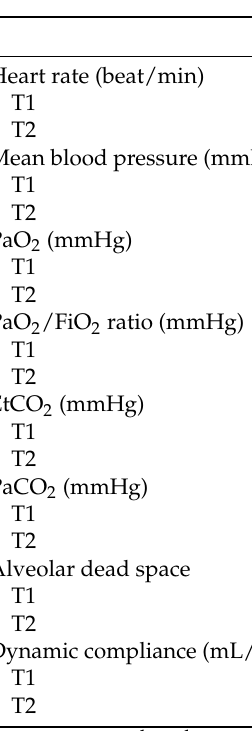
Table 3. Effects of iloprost on hemodynamics and lung